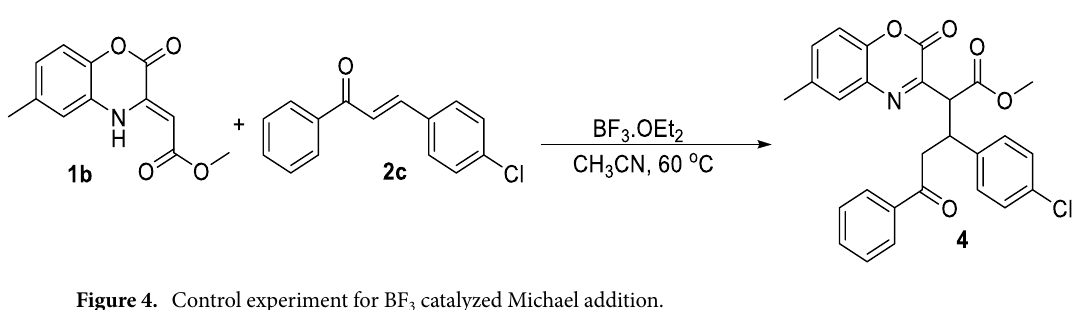
Figure 4. Control experiment for BF 3 catalyzed Michael